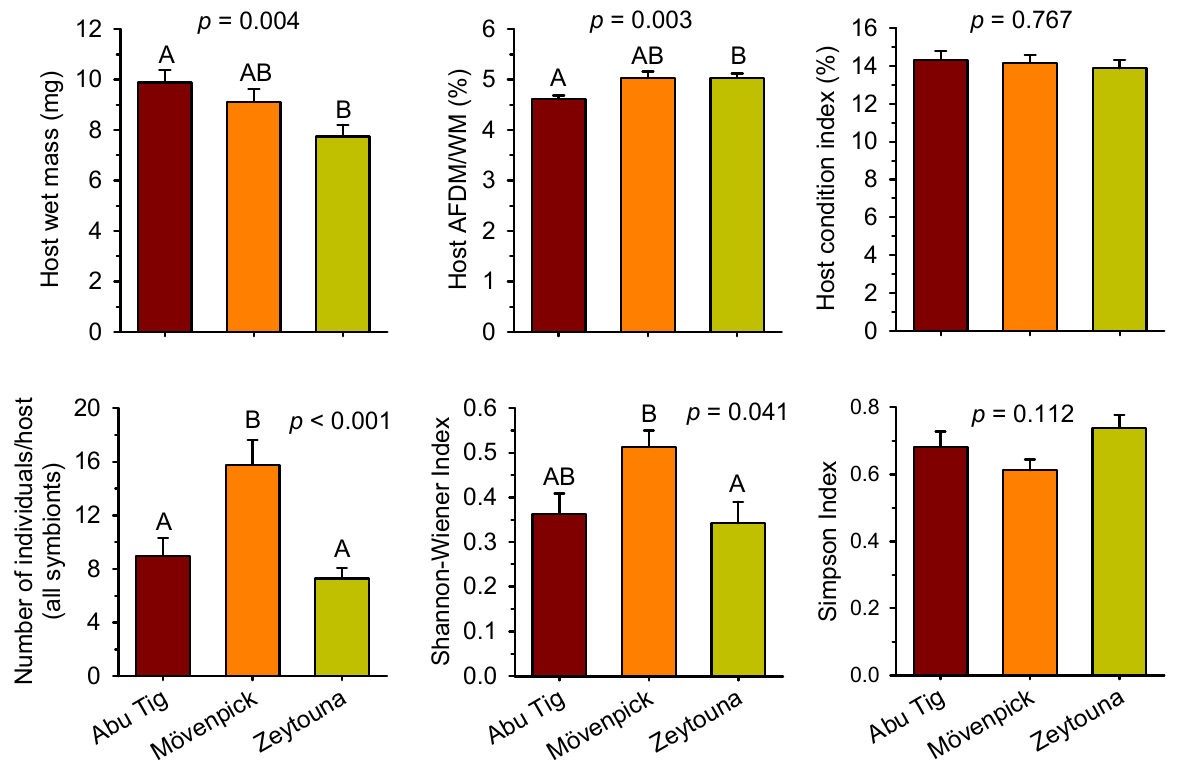
Figure 3. Wet mass, ash-free dry mass per wet mass (AFDM/WM), and condition of the ascidian Phallusia nigra collected at three reefs from El Gouna, Egypt (top row). Associated fauna (total ascidian symbionts) and two indices of species diversity of symbionts (Shannon-Wiener and Simpson indices) are presented on the bottom row. Bars represent means ± 1 SE. P values are from one-way ANOVA or Kruskal-Wallis tests, followed by appropriate pairwise comparisons as needed (see Methods). Same letters above bars indicate statistically equivalent means. Fill colors of bars are maintained between some figures to facilitate comparisons.